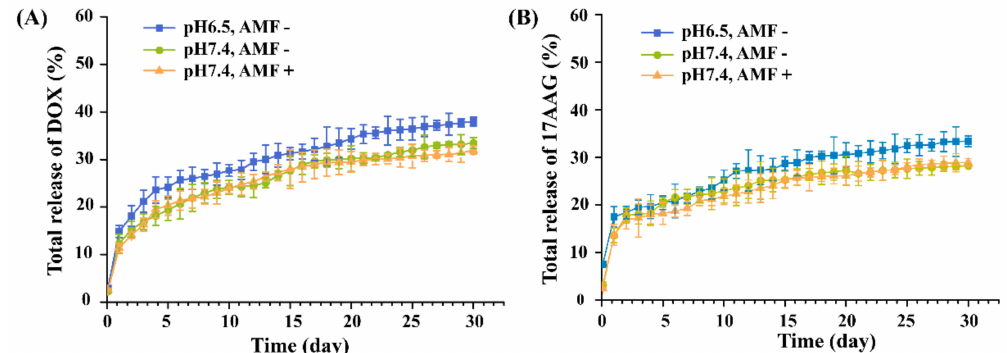
Figure 3. ( A ) DOX and ( B ) 17AAG release profile from the MNP/DOX/17AAG-PCL nanofiber mesh at different pH and with or without AMF